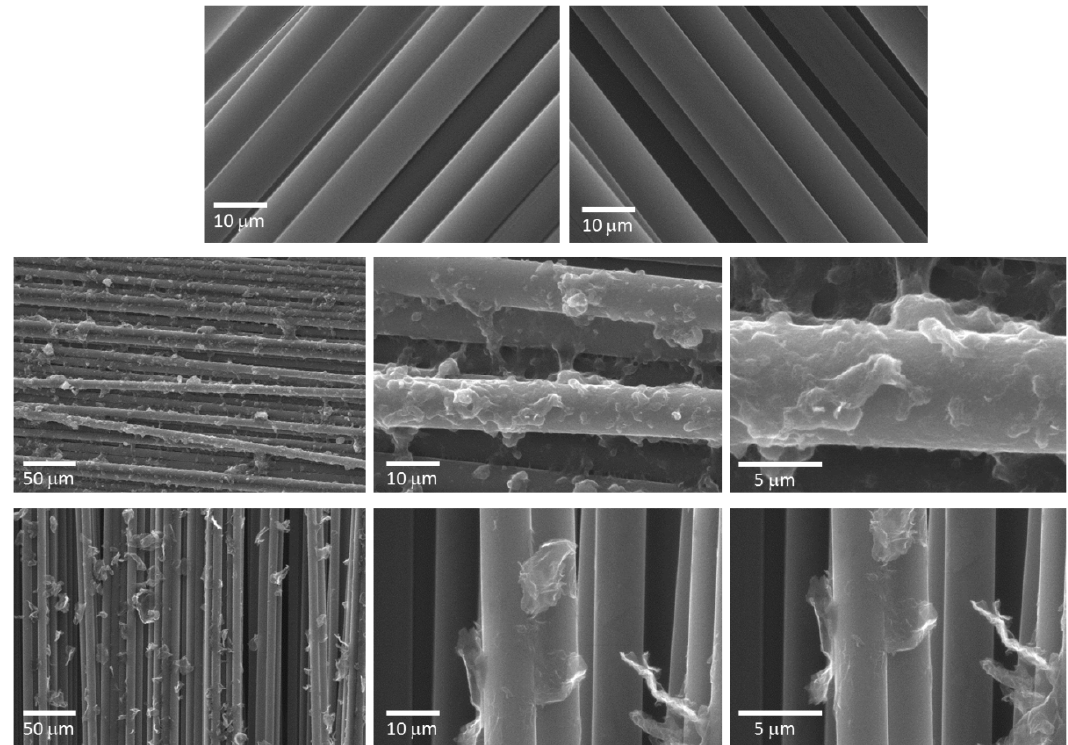
Figure 2. Scanning electron microscopy (SEM) images of carbon fiber surfaces: original fiber (top left), spraying only with ethanol (top right), spraying with CNT dispersion (middle), and spraying with graphene dispersion (bottom).